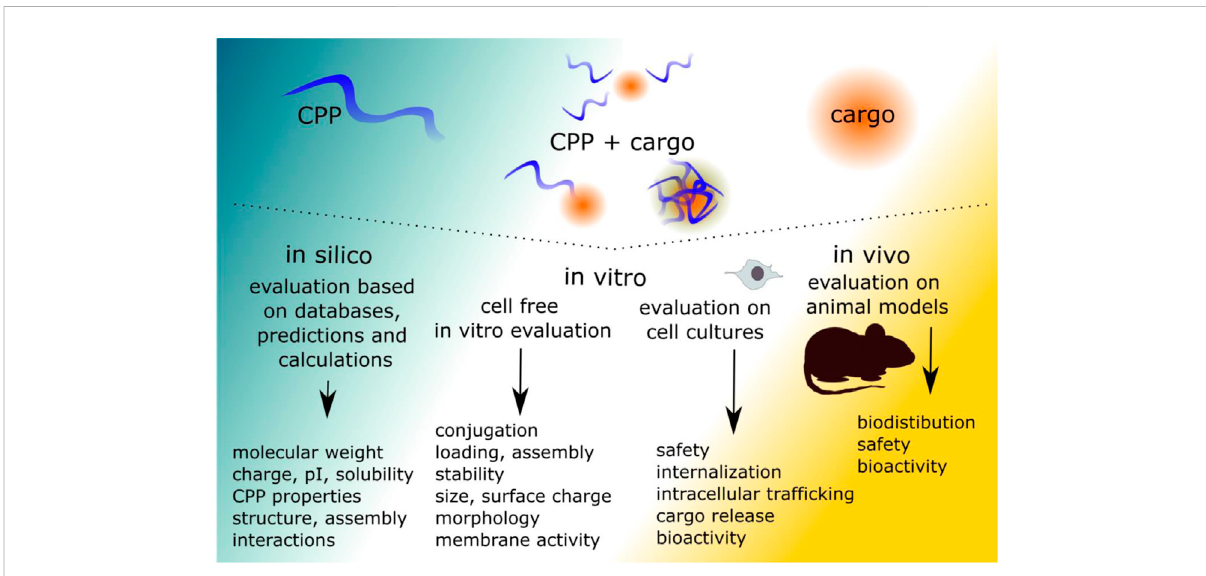
FIGURE 2 The evaluation of the CPP-cargo consists of several levels. The initial evaluation can be done by using in silico approaches, but as CPP-cargo systems are complicated, the evaluation should be continued to determine the aspects of the CPP-cargo. If the desired CPP-cargo